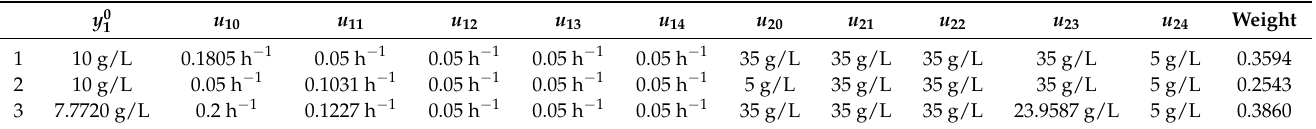
Table 13. Optimal design ξ ADAGPR computed with the novel ADA-GPR for the yeast fermentation.